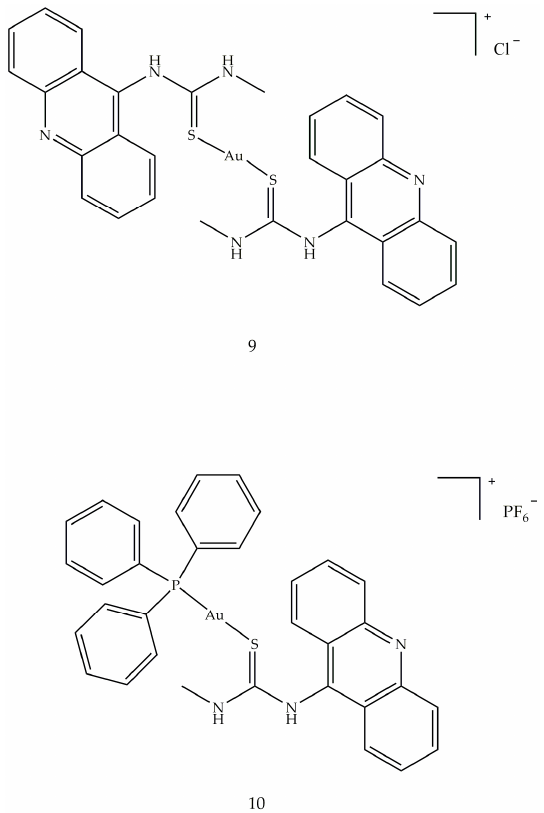
Figure 11. Molecular structure of acridine thiourea gold (I) (9 and 10).